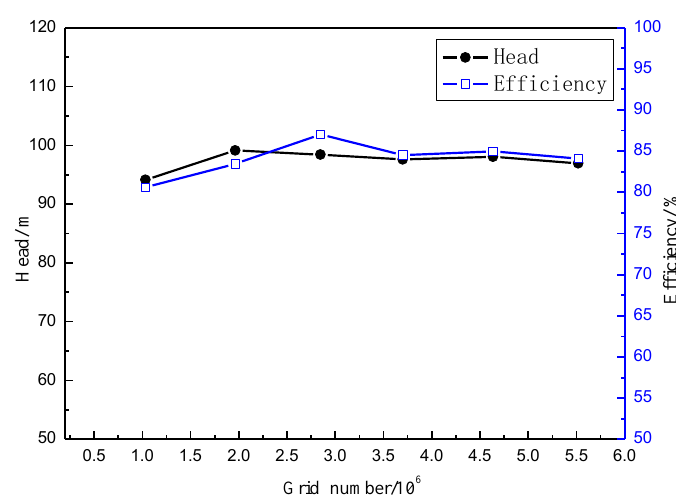
Figure 6. Predicted head and efficiency values with different grid numbers. Table 3. Mesh information for